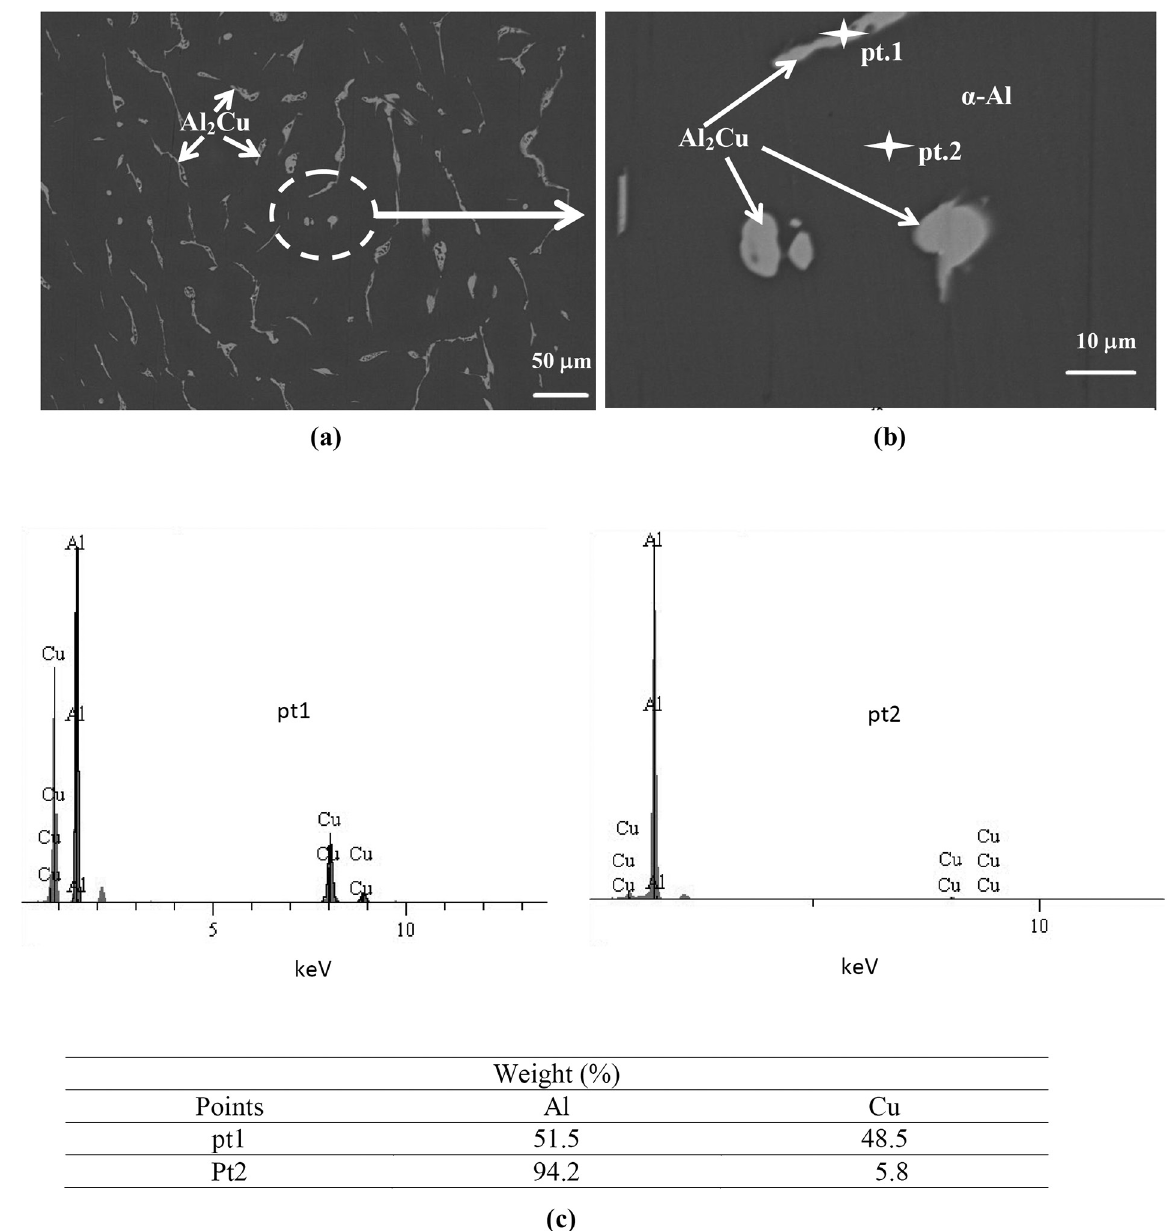
Figure 5 - Typical SEM micrograph and EDAX patterns of a Al-6wt.%Cu alloy sample at 40 mm (V = 235.9 μ m) from the cooled surface of the casting for Al-6wt.%Cu alloy: ( a ) Accelerating Voltage: 20 kV; and K/s and λ 1 Magni fi cation: 200; ( b ) Accelerating Voltage: 20 kV and Magni fi cation: 1500; ( c ) EDAX patterns and the corresponding chemical